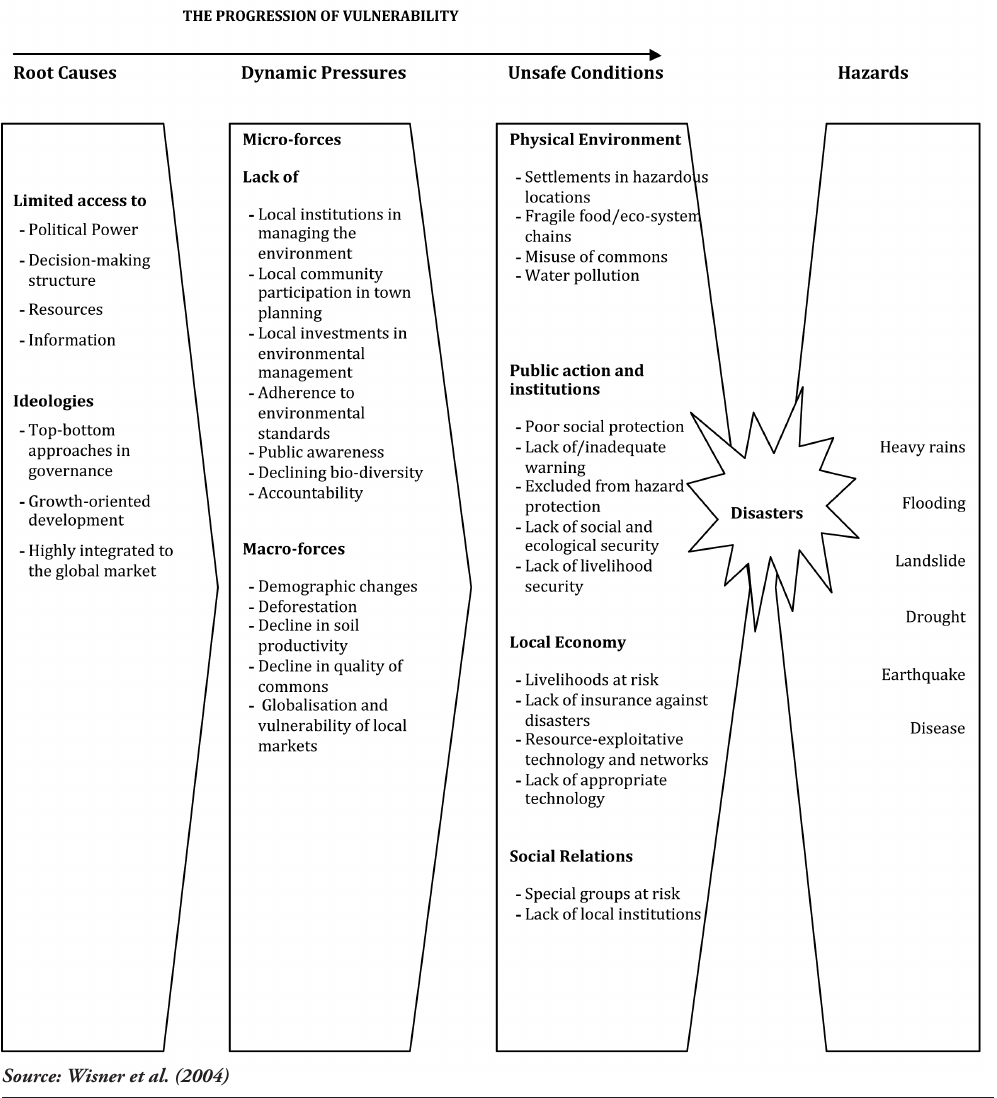
Population vulnerability and disaster risk reduction: A situation analysis among the landslide a ff ected Fig 6: Modified from Pressure and Release (PAR) Model